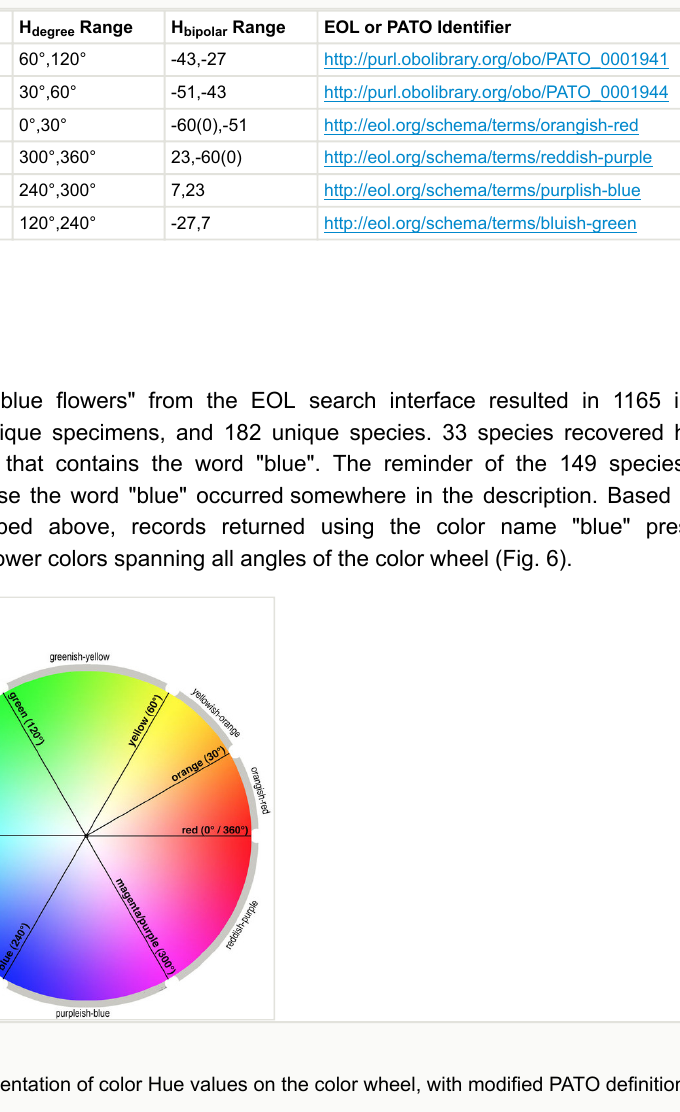
Table 2. Range hue values for proposed intermediate colors as represented in RGB, HSV, Hbipolar color models, and PATO or EOL URI.